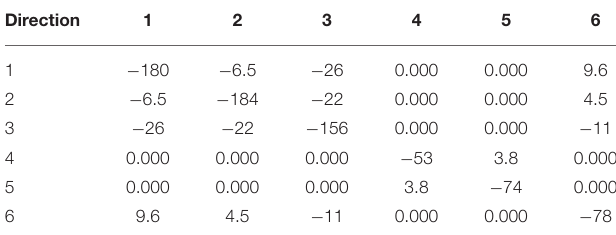
TABLE 10 | Elastic moduli λ E ij at constant electric field E of α -DIPAB crystal